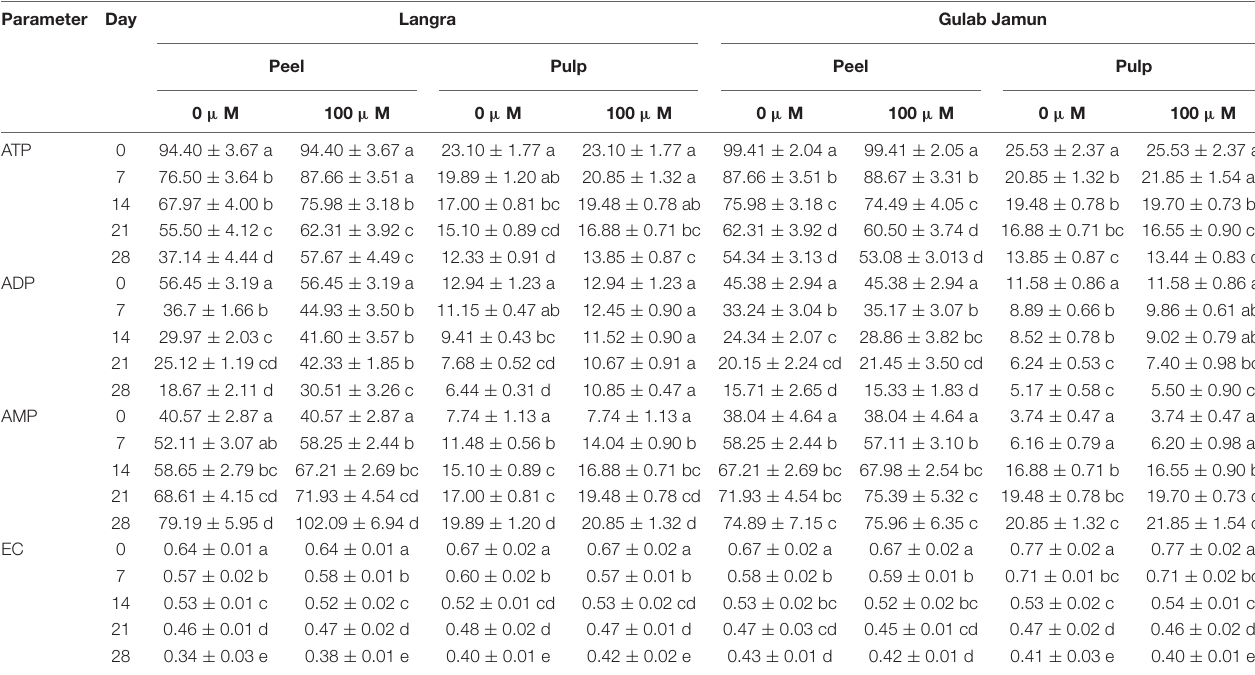
TABLE 2 | Adenosine triphosphate (ATP), adenosine diphosphate (ADP), adenosine monophosphate (AMP), and adenylate energy charge (AEC) in peel and pulp of ‘Langra’ and ‘Gulab Jamun’ mangoes treated with 0 µ M (control) or 100 µ M (treated) melatonin for 2 h followed by low temperature storage at 5 ± 1 ◦ C. Parameter Day